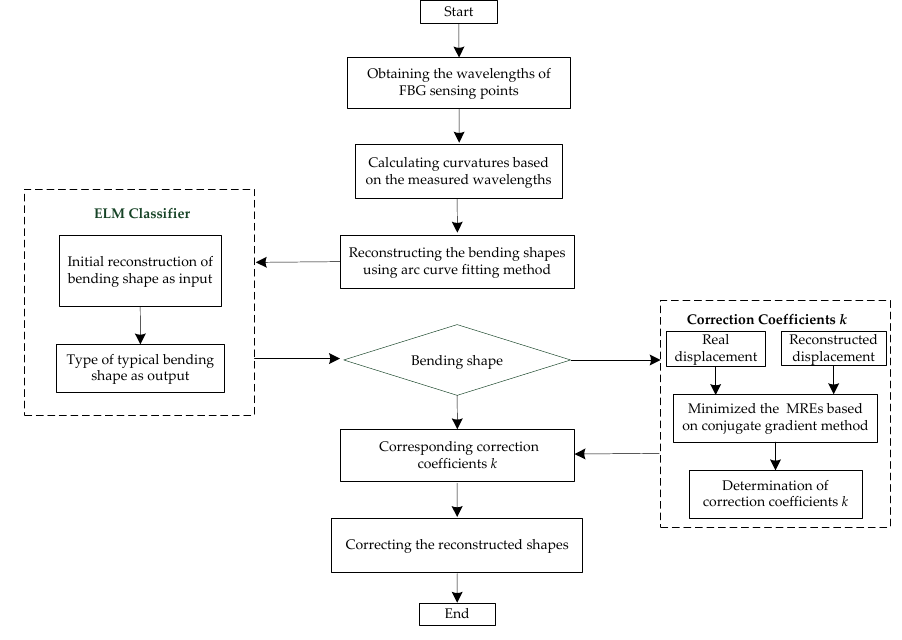
Figure 8. Flow chart of classification morphological correction method based on ELM intelligent algorithm.